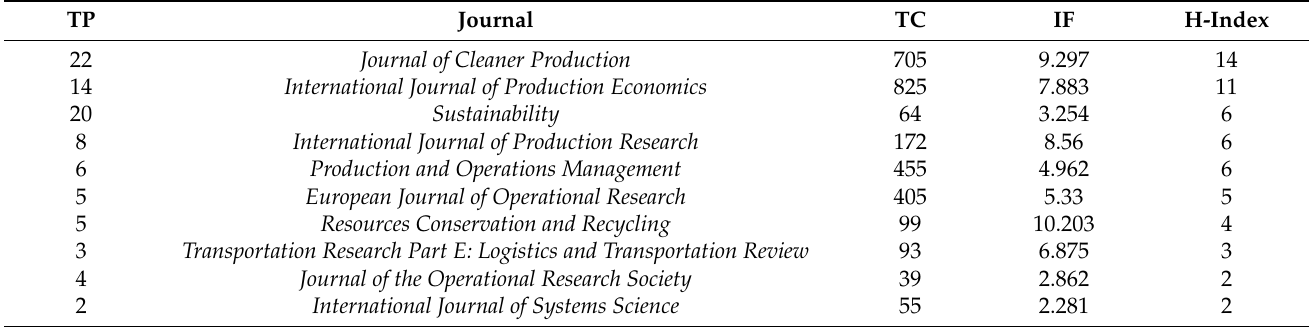
Table 2. The performance of the 10 most leading